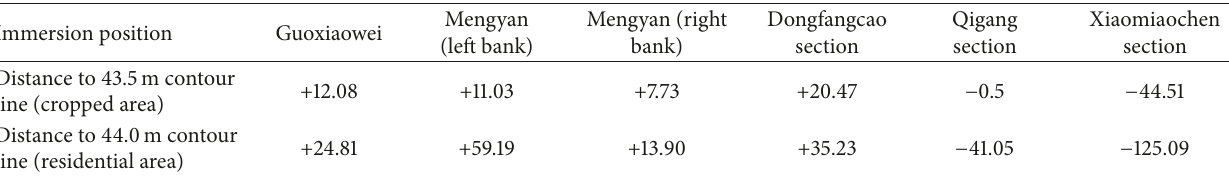
Table 5: The distance between the immersion zone and the 43.5 m and 44.0 m